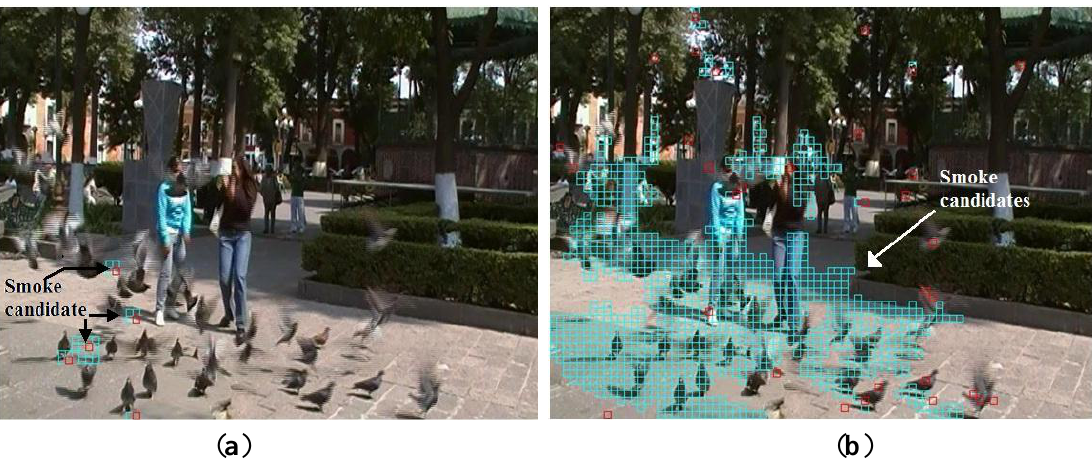
Figure 5. Smoke candidate region detection. ( a ) using morphological operation ( b ) without morphological operation.